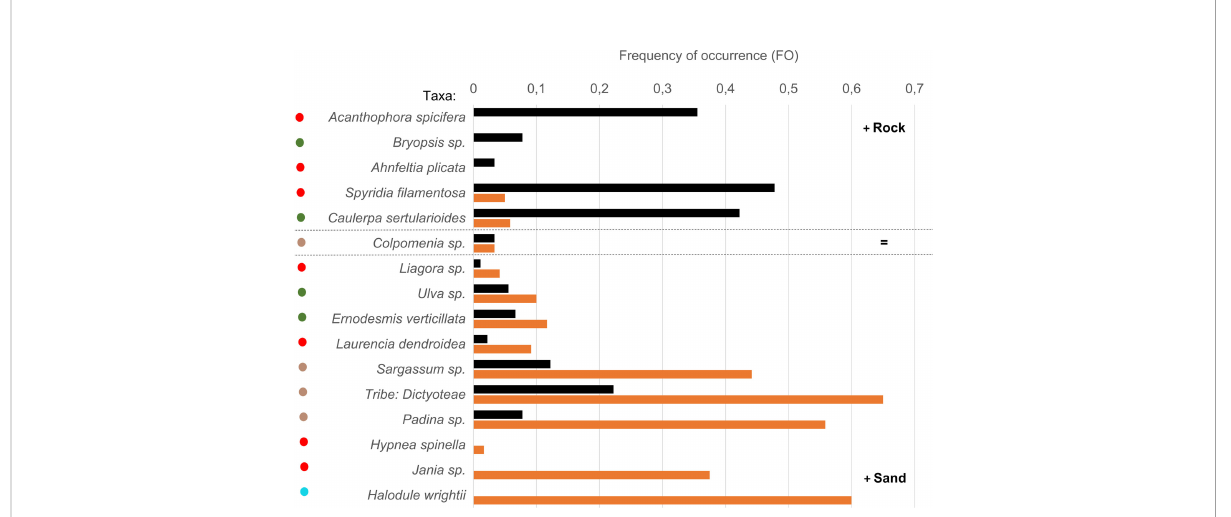
FIGURE 2 Frequency of occurrence of the benthic algae/seagrass taxa identi fi ed at Unhocomo and Unhocomozinho green turtle foraging grounds. Taxa are ordered from top to bottom from most common at the rocky-bottom habitat (black) to most common at sandy-bottom habitat (orange). Color coding on the left represents taxonomic groups – red, rhodophyta; green, chlorophyta; brown, ochrophyta; blue, tracheophyta